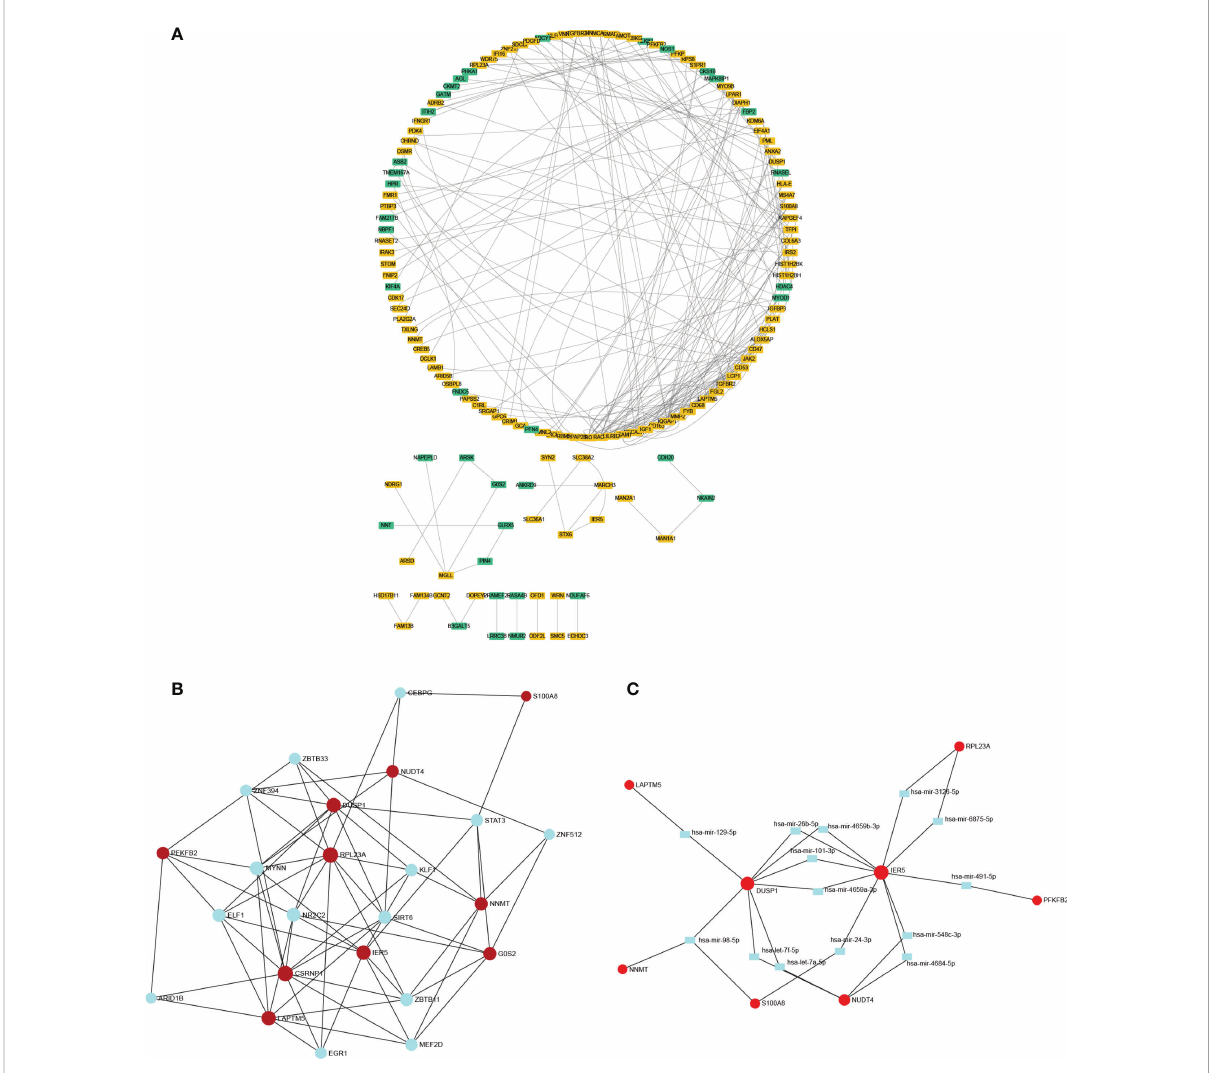
FIGURE 3 The PPI network and interaction network of DEGs. (A) The PPI network of DEGs was constructed through Cytoscape. (B) Interaction network linking top 10 DEGs to transcription factor. (C) Interaction network linking top 10 DEGs to